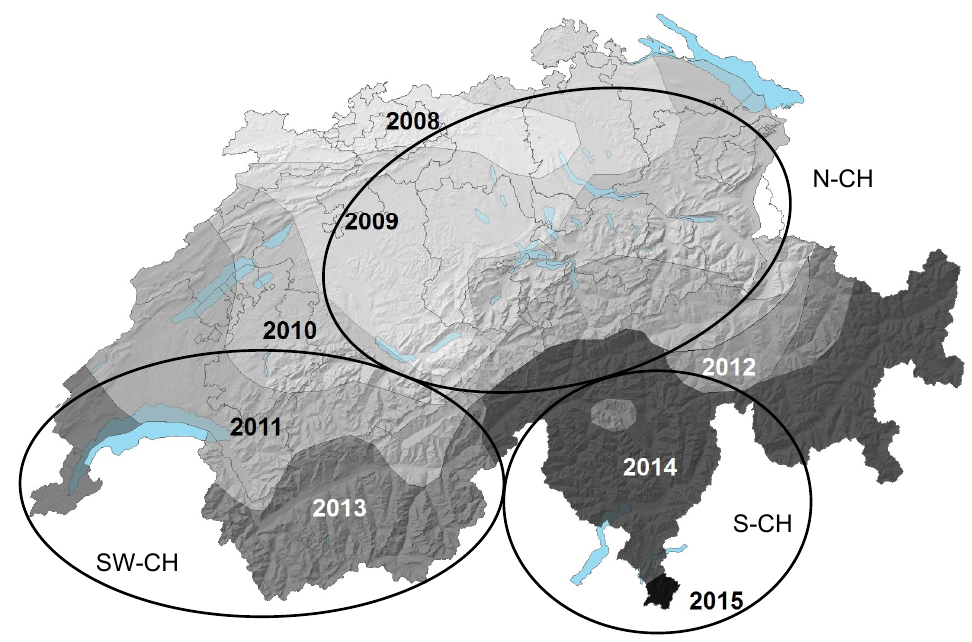
Figure 1. Geographic origin of the Swiss Hymenoscyphus albidus and H. fraxineus samples analyzed in this study. Grey tones display the year of first report of ash dieback. Light grey lines display Swiss canton borders. Abbreviations: S-CH: Southern Switzerland, SW-CH: South-Western Switzerland, N-CH: Northern Switzerland. Modified after [41].